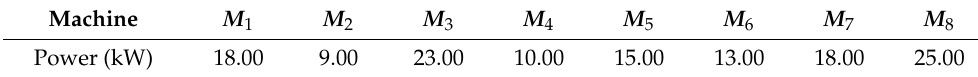
Table 3. Power of standby of each stage’s machine.